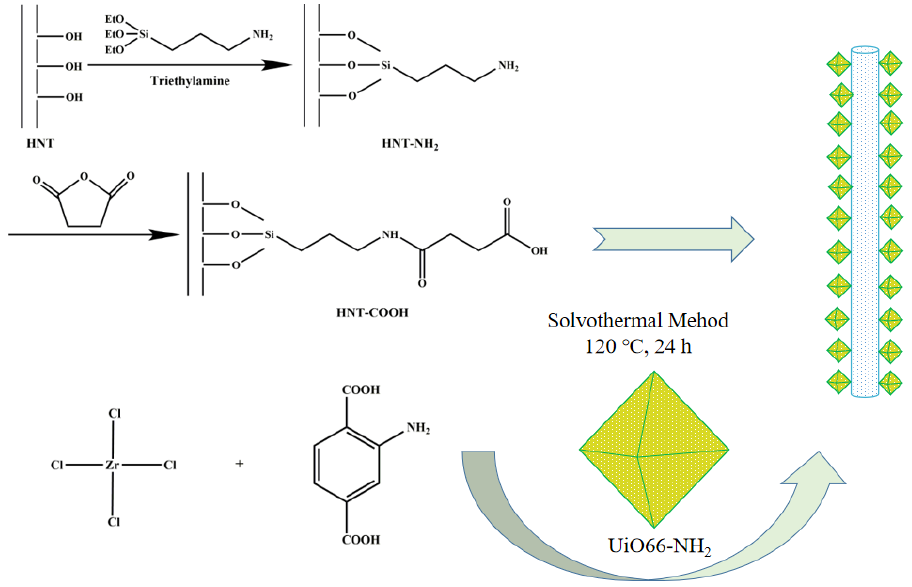
Figure 1. The synthesis of H-U.